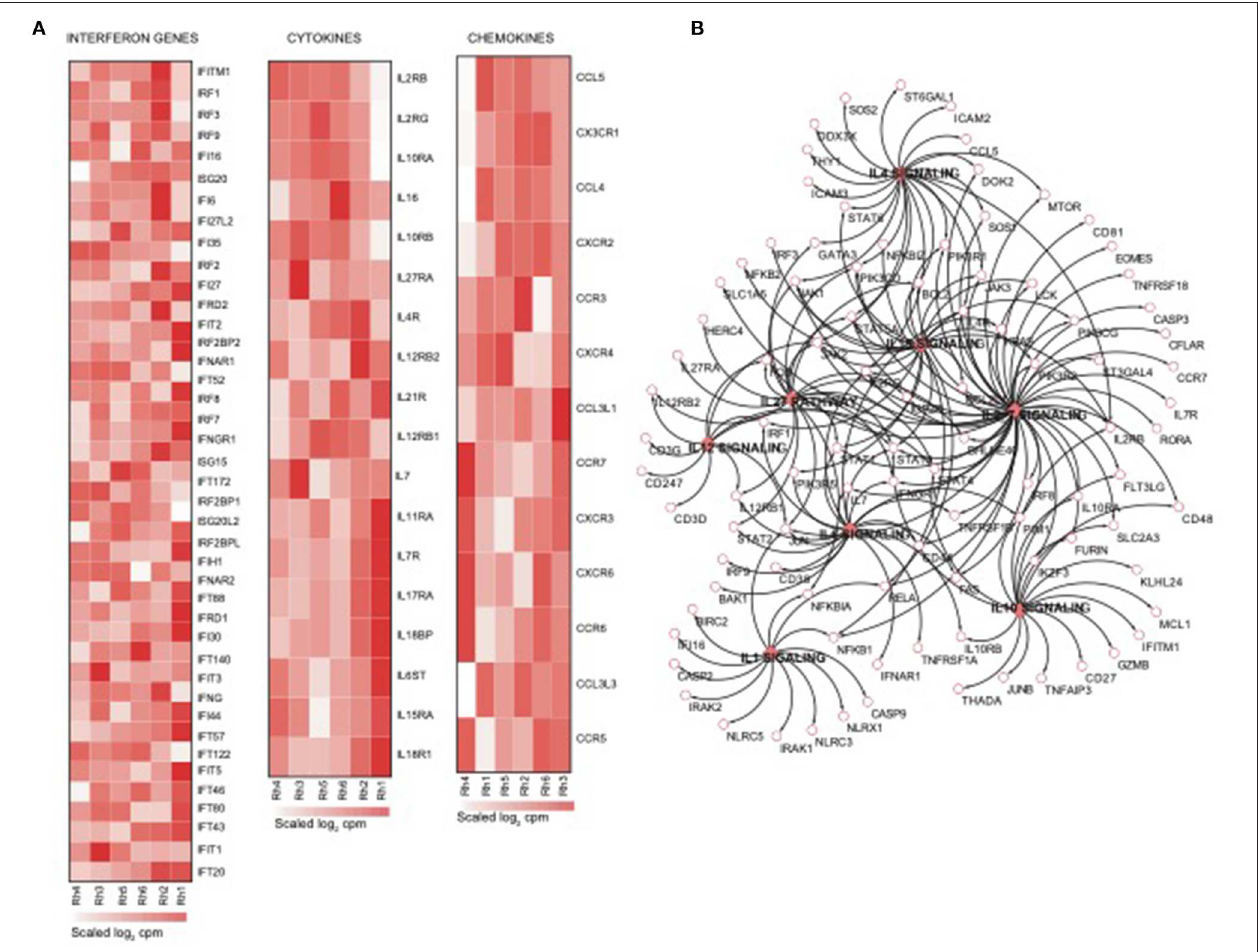
FIGURE 4 | NK cell transcriptomic profile is enriched in interferon genes, cytokines and chemokines and their downstream signaling. (A) Heatmaps representing the normalized expression of interferon genes, cytokines and chemokines enriched in the NK RMtsig. Each column represents an individual animal and each row represents a gene. (B) Genes network representing the cytokines downstream signaling enriched in NK RMtsig. Genes shared by two pathways or higher were highlighted in full red boxes. Unique genes for each pathway were shown in empty boxes. The red color gradient corresponds to the number of pathways which a specific gene belongs.